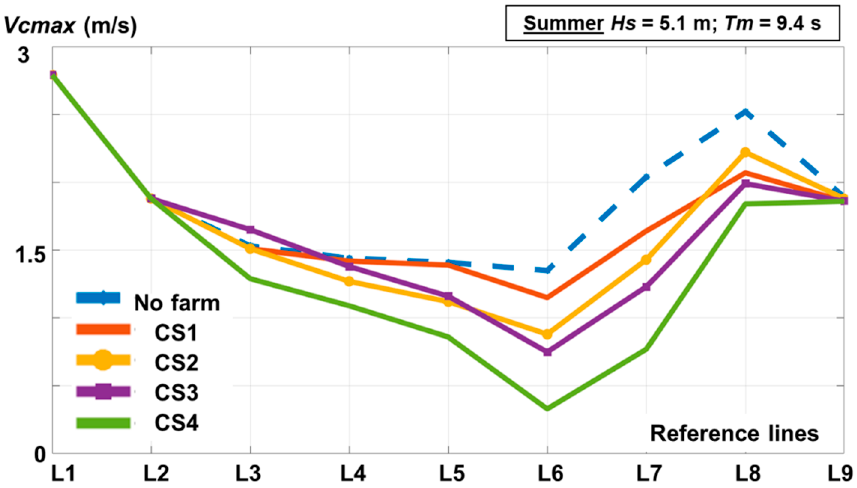
Figure 12. Maximum values of the nearshore current velocities along the reference lines considered. The results correspond to a high energy summer event (Summer B).